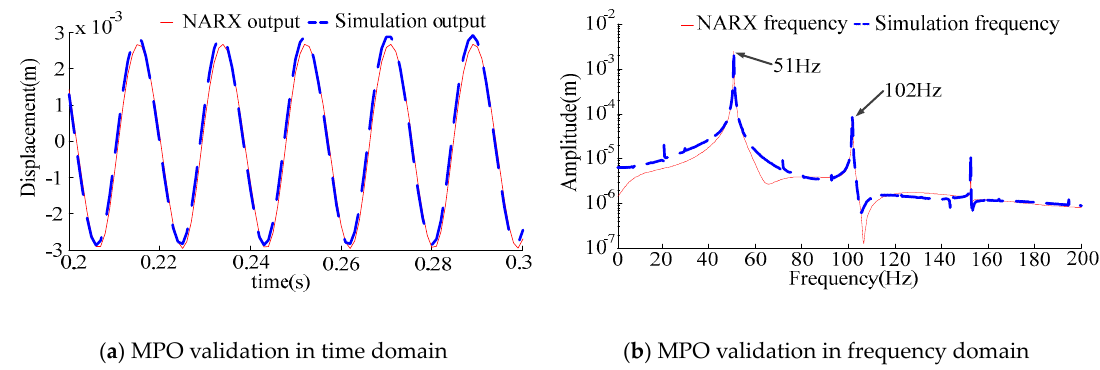
Figure 10. Output comparison in time and frequency domain at a critical speed.